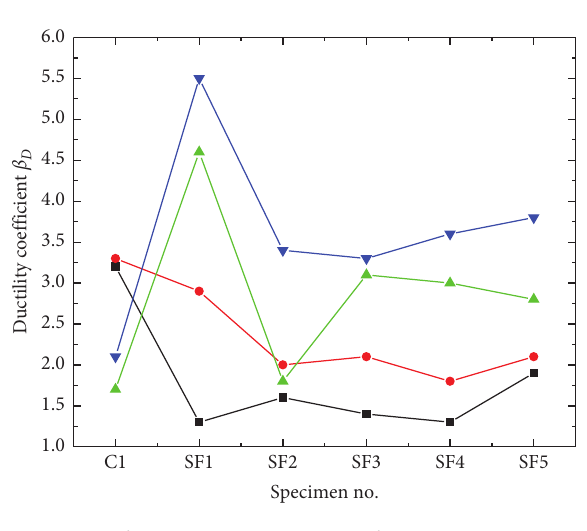
85 and θ 75 of six